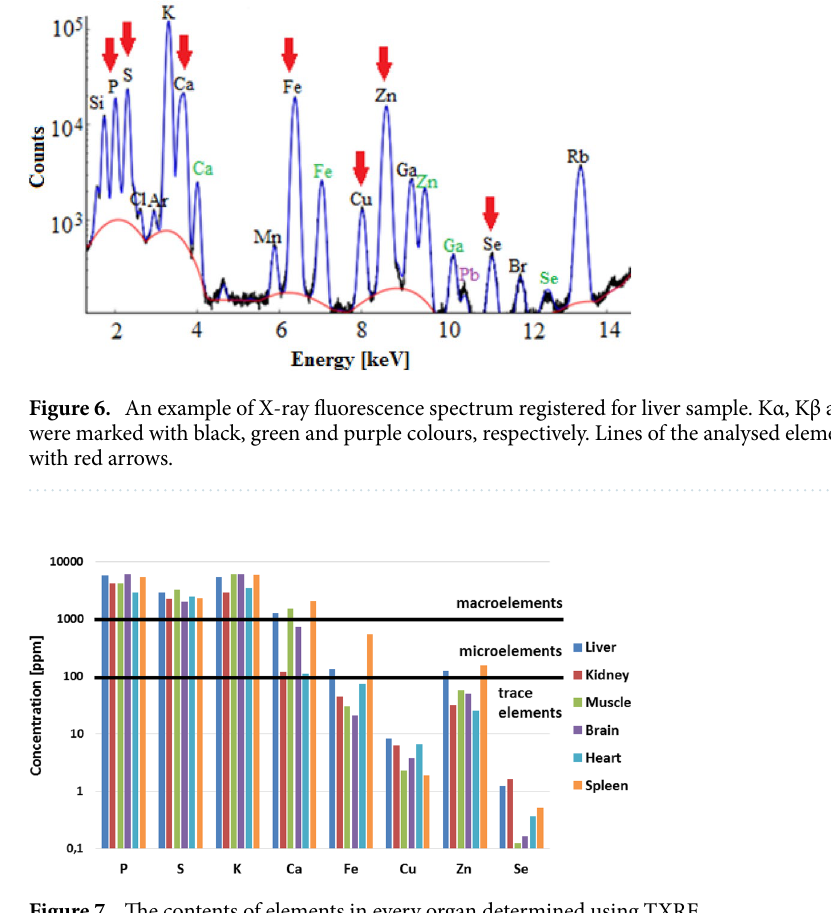
Figure 7. The contents of elements in every organ determined using